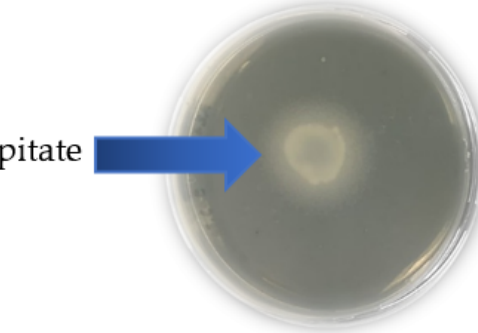
Figure 1. Lipolytic activity on Tween 80 substrate by formation of calcium oleate precipitate.